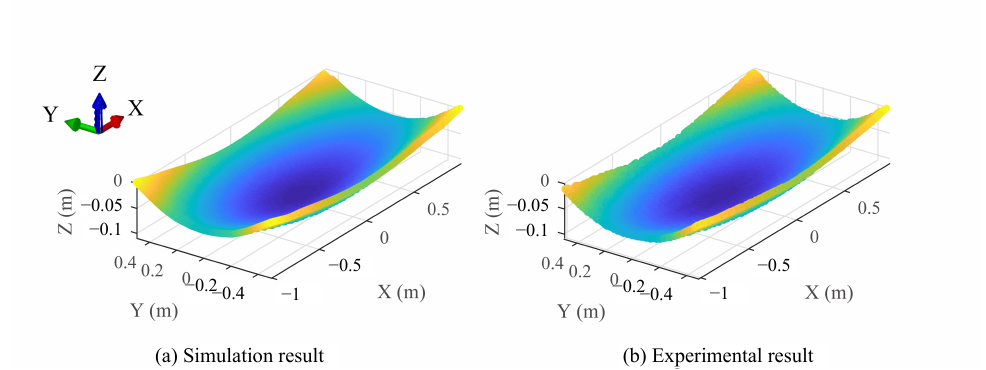
Figure 19. Shape of deformed plate ( a ) simulation result, ( b ) experimental